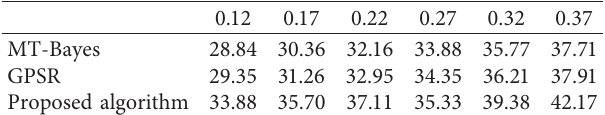
Table 2: The effect comparison of